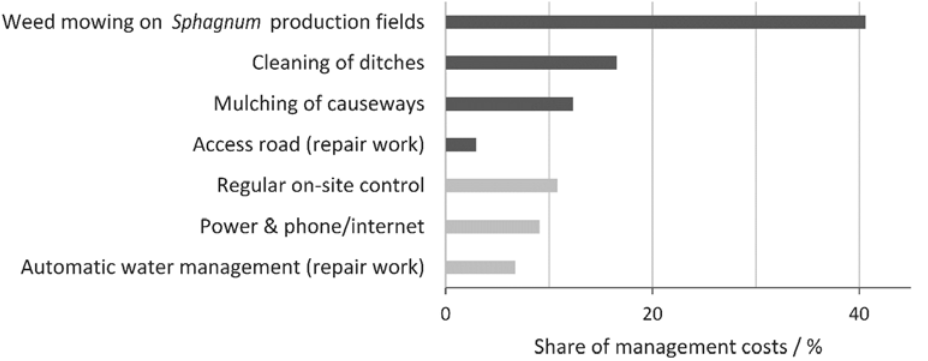
Figure 4. Management costs in 2011–2016 showing the shares of the single cost items for site maintenance (dark grey) and water management (light